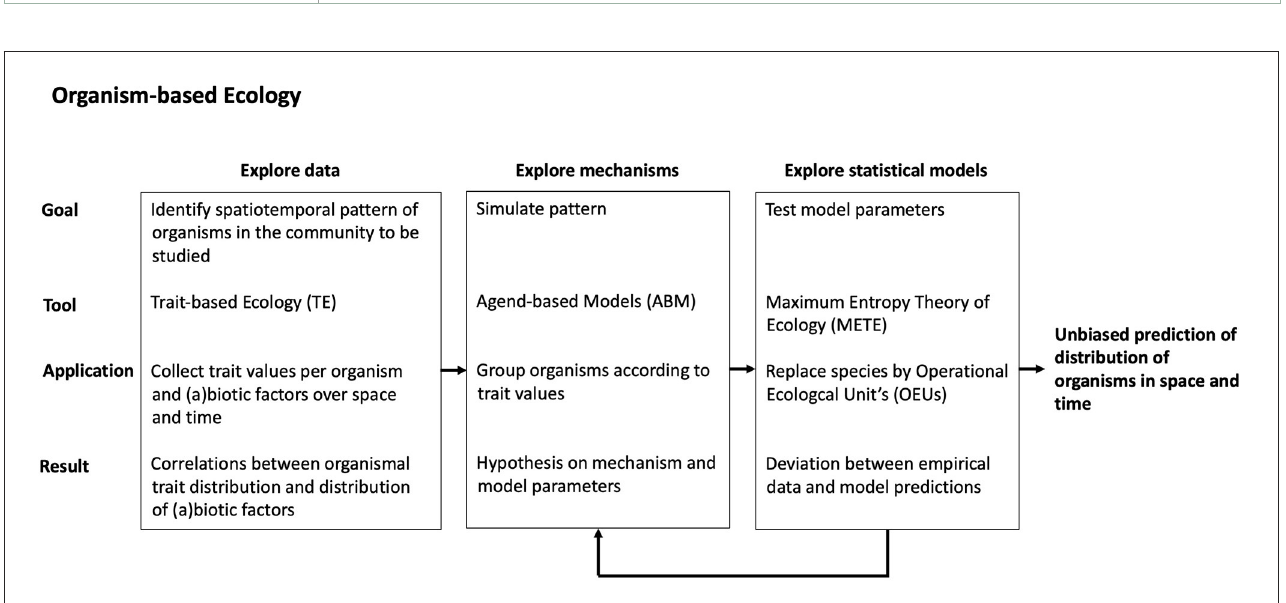
FIGURE1 Tentative procedure of Organism-based Ecology